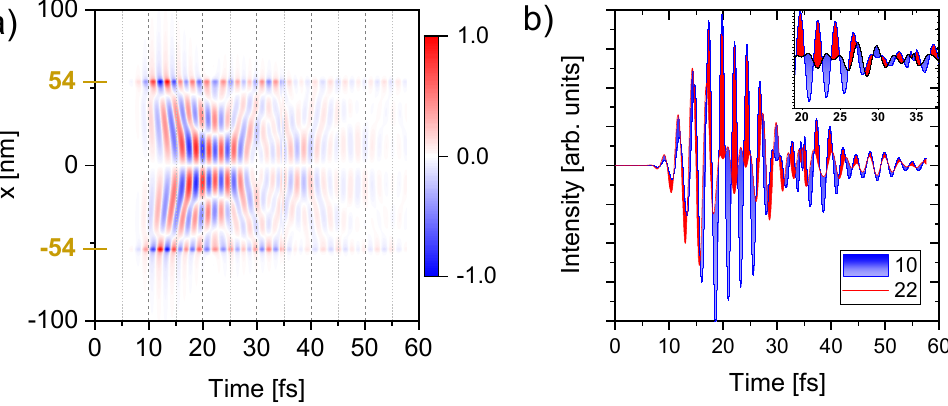
Figure 6. Electric field along a line on the surface ( a ) and the field on two positions at 10 and 22nm ( b ). The observed line is parallel to the incident